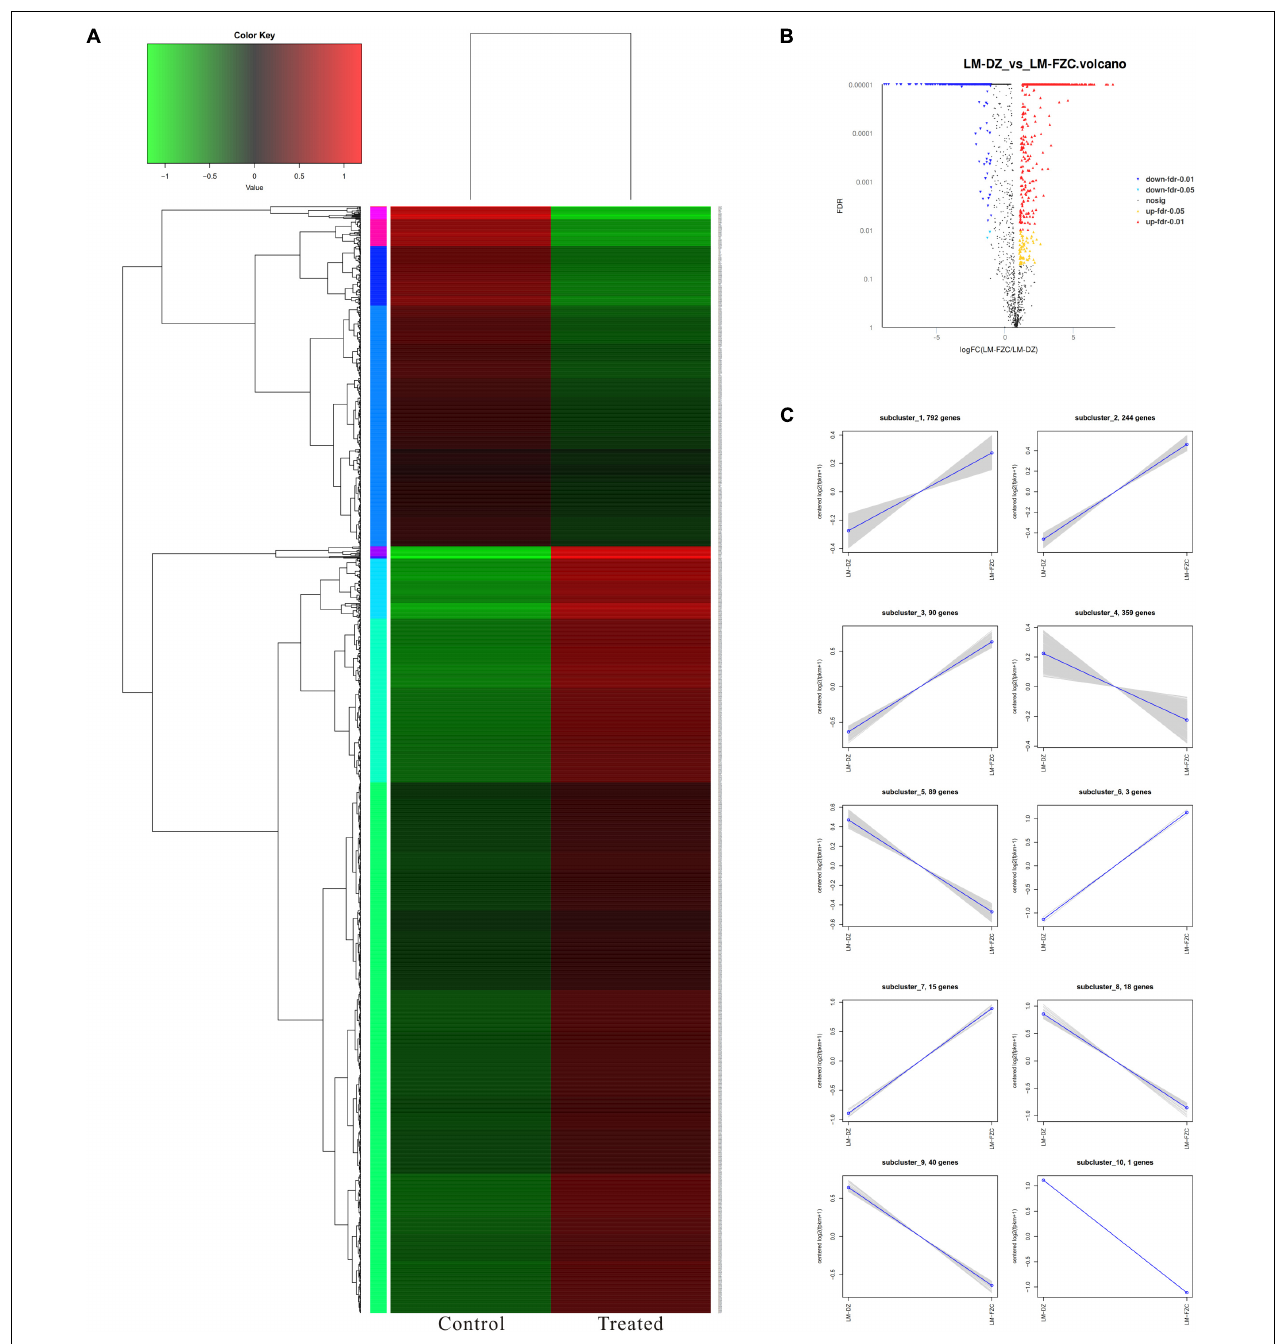
FIGURE 6 | Differentially expressed genes (DEGs) analyzed in L. monocytogenes planktonic cells between treated group (treated with linalool) and control group (untreated with linalool). (A) Heat map of DEGs. Red cluster indicated up-regulated genes and blue cluster indicated down-regulated genes. (B) Volcano plot of DEGs. Percentages of up-regulated and down-regulated genes for each group indicated on a volcano plot. (C) log2 (ratio) line chart. Gray lines were relative expressions of genes in different groups. Blue lines were average values of relative expressions of genes in different groups.